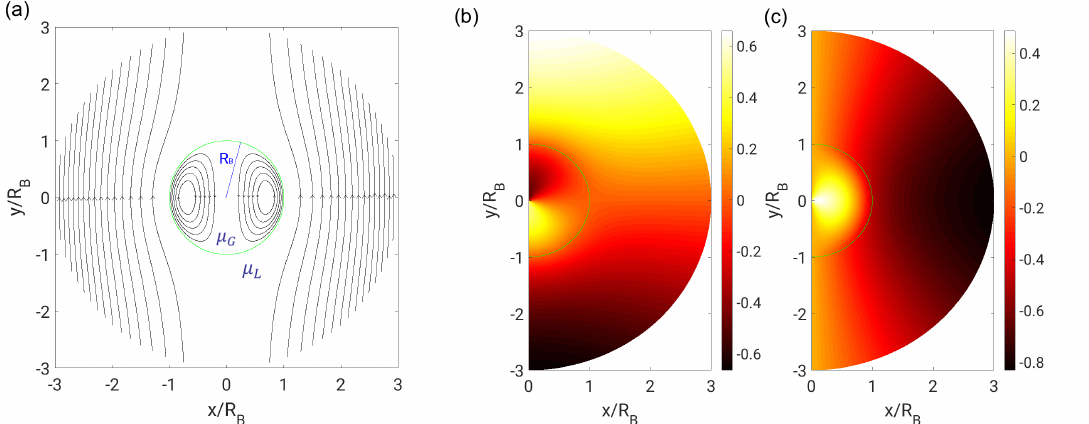
Figure 2. ( a ) Streamlines; ( b ) radial velocity u r ; and ( c ) circumferential velocity u θ in the bubble case ( ξ = 0.0182) with far-field boundary